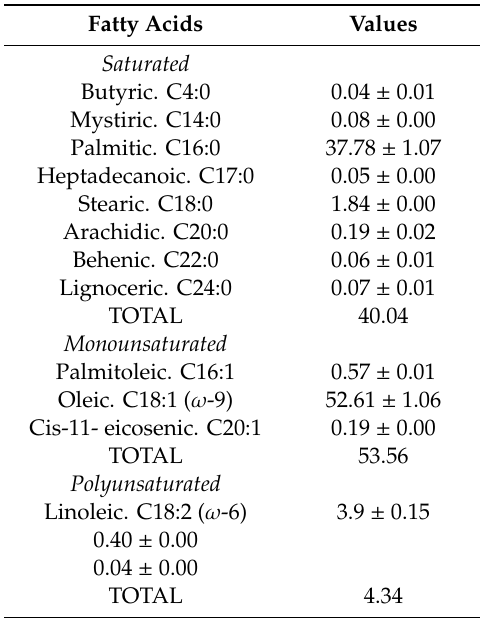
Table 2. Fatty acids profile of Caryocar brasiliense pulp oil (% in area). Fatty Acids